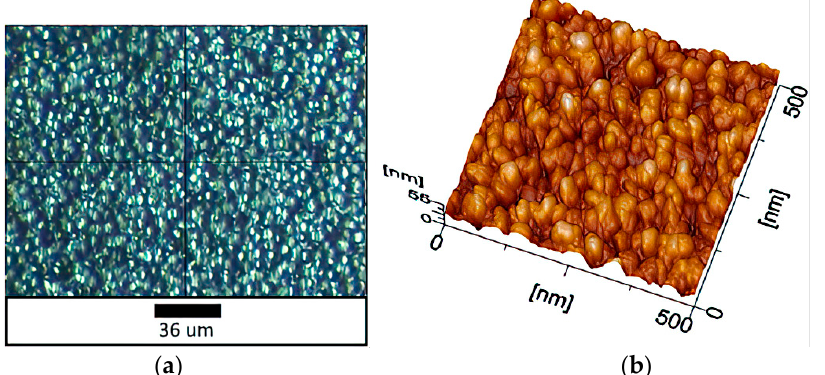
Figure 4. AFM images of a sample with 25 coating layers: ( a ) optical microscopy; ( b ) 500 × 500 nm (topography mode).